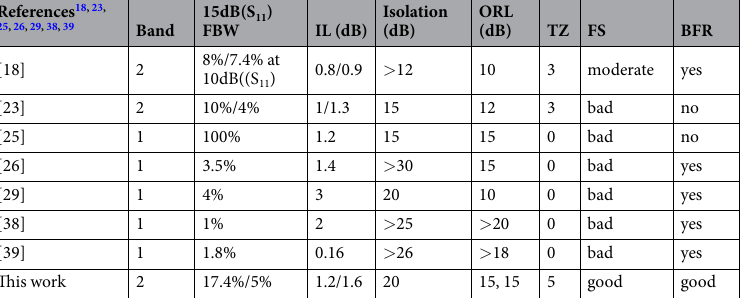
Table 3. Comparison with some prior filtering power dividers. FBW: fractional bandwidth; IL: Insertion Loss; ORL: output return loss; TZ: transmission zero; FS: Freq. selectivity; BFR: bandpass filtering